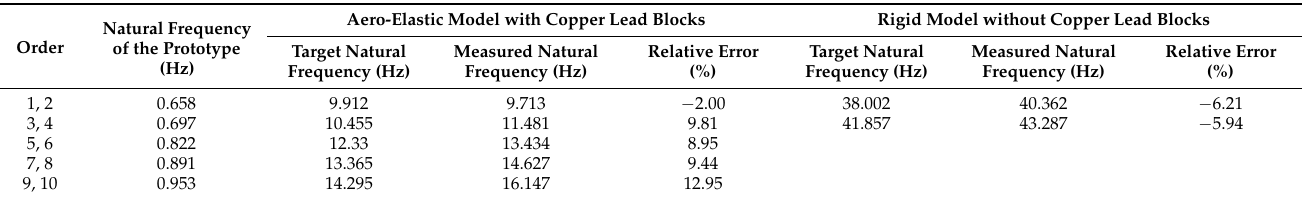
Table 1. Natural frequencies measured on the aero-elastic model.